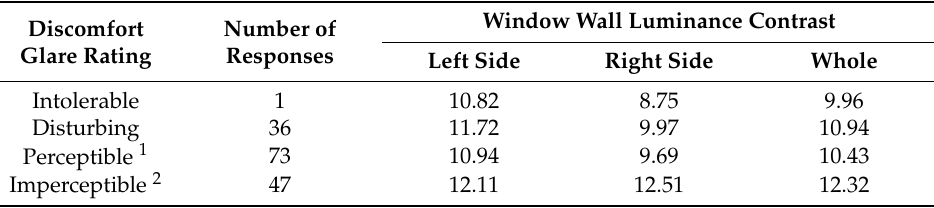
Table 4. Average luminance contrast for each level of perceived glare during experimental lighting conditions.